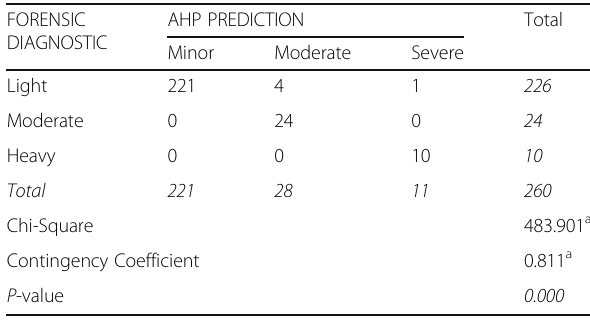
Table 8 Comparison of diagnostic grade classification result